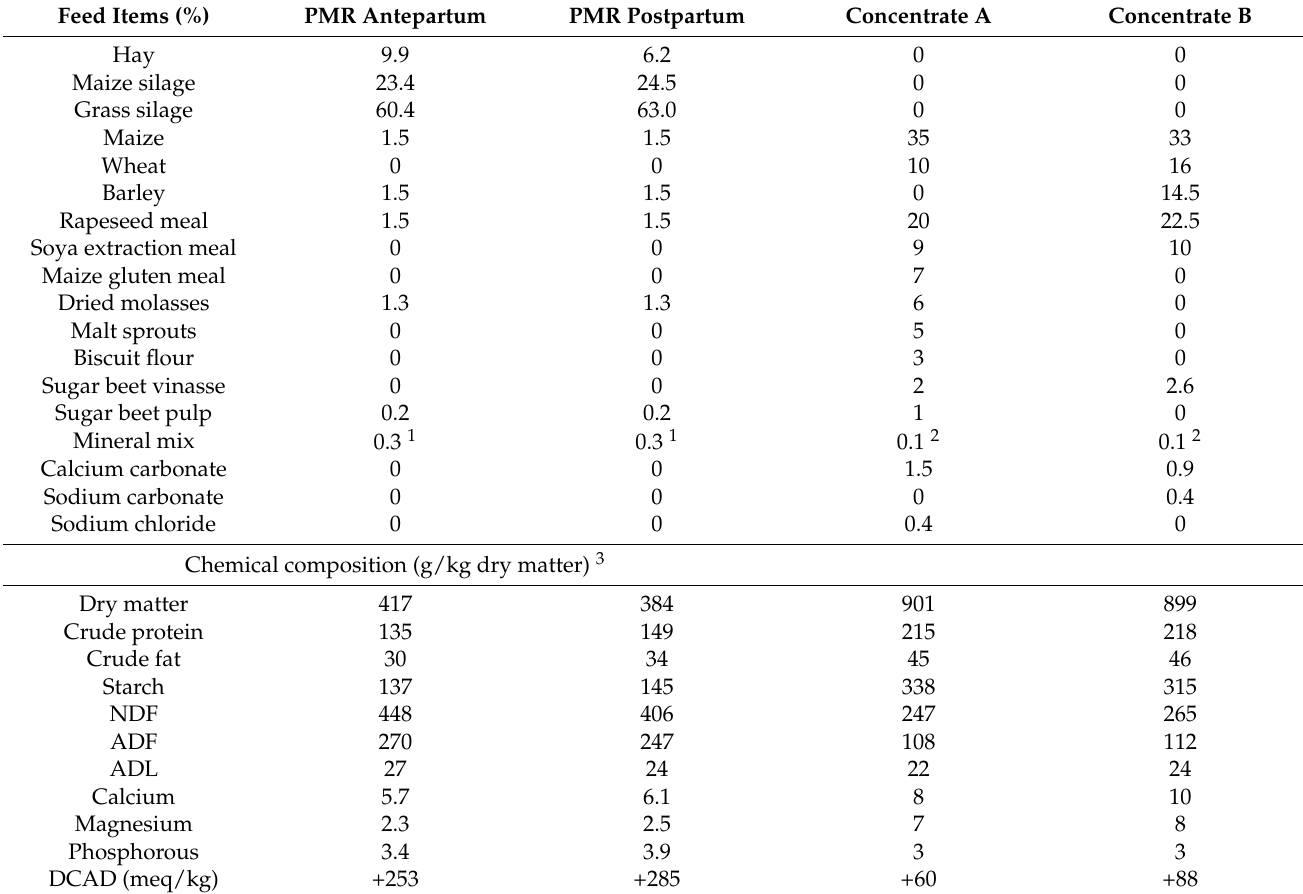
Table 1. Diet ingredients and chemical composition of partial mixed ration (PMR) fed to dairy cows antepartum and postpartum, as well as of concentrates supplied by the automatic milking system